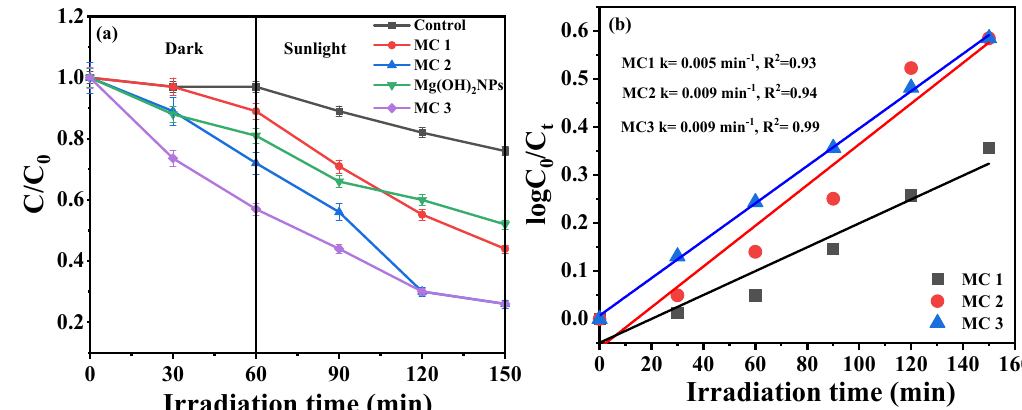
/CdS hetero nanostructures 2